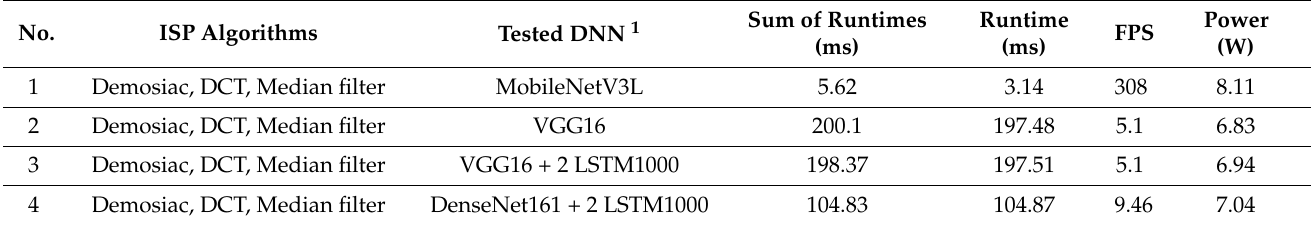
Table 6. The experiment results for the complete vision